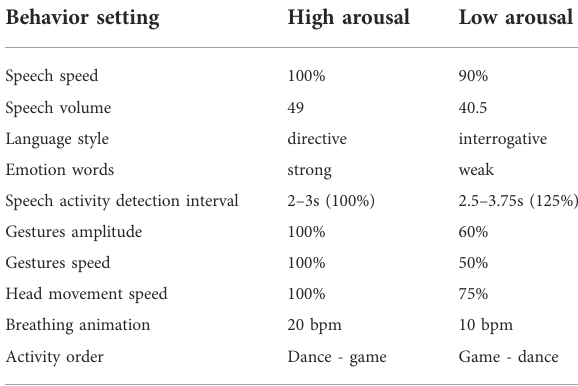
TABLE1Behaviorsettingsforthetwoarousal-basedbehaviorpro fi les. Behavior